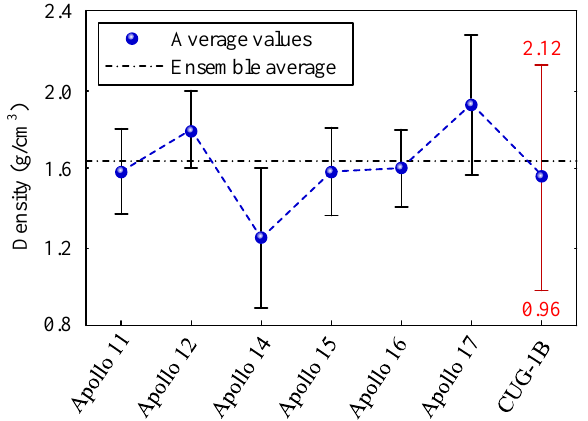
Figure 2. The comparison of lunar soil simulant and lunar regolith’s density.